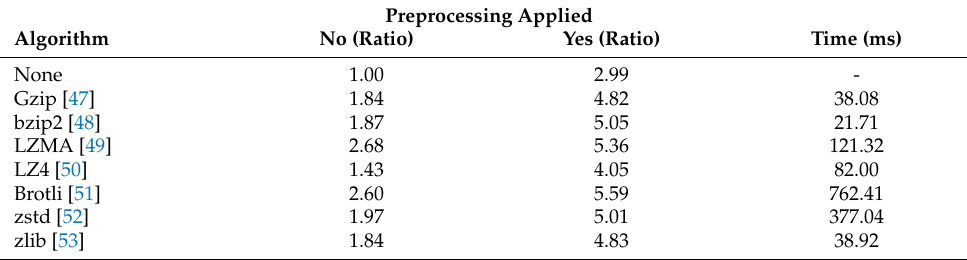
Table 4. Combining our preprocessing strategy with generalized compression